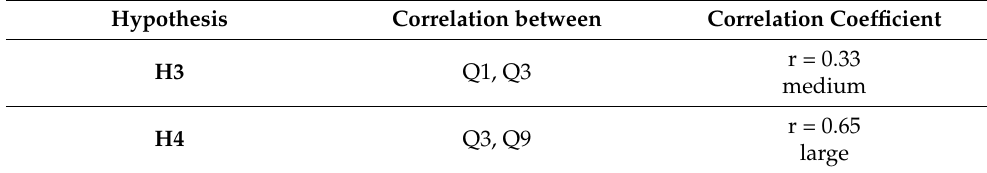
Table 4. Overview of Spearman correlation analyses between the results of selected questions. Hypothesis Correlation between Correlation Coefficient H3 Q1, Q3